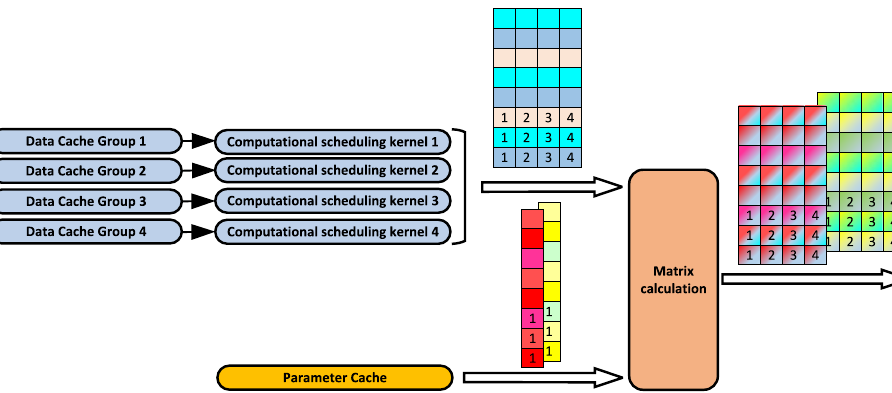
Figure 4. Input channels are 3. Input parallelism is 8. Output parallelism is 8. Pixel parallelism is 4. Internal data flow diagram of the Computational